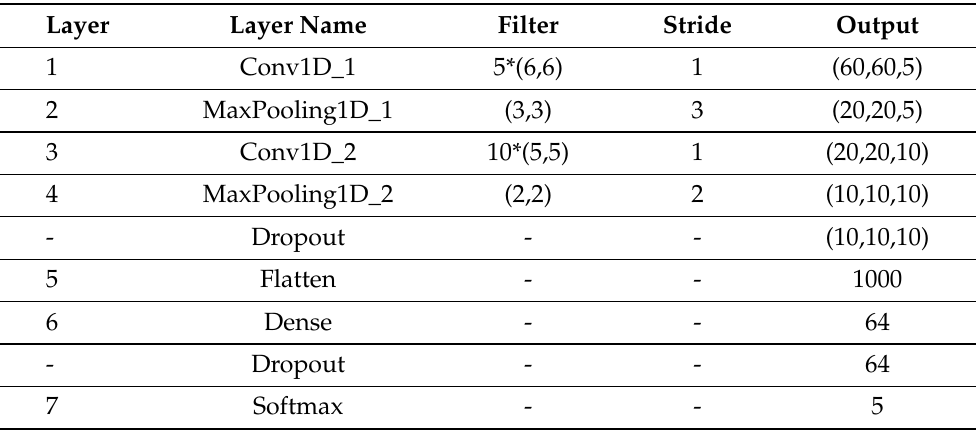
Table 3. The main parameters of CNN